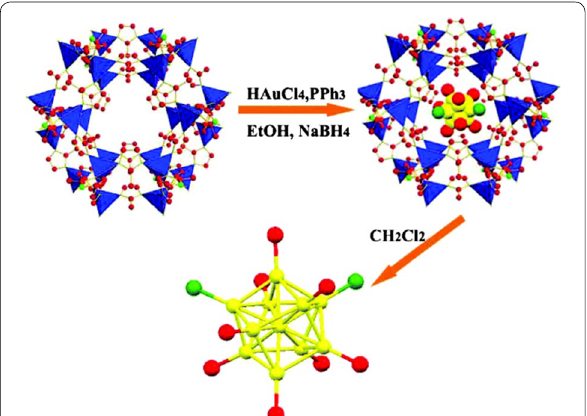
Fig. 6 Schematic representation of Au NC synthesis in a framework and preparation of Au 11 NCs@ZIF-8 (Reproduced from Ref. [67] with permission from the Royal Society of